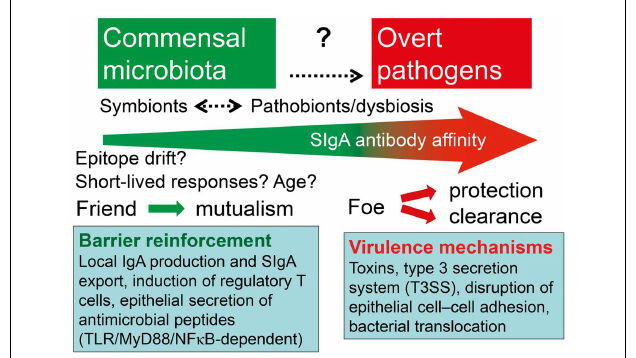
FIGURE 8 | Hypothetical depiction of how the intestinal immune system handles symbionts and potentially pathogenic residents (pathobionts) of the commensal microbiota versus overt exogenous pathogens . Secretory IgA (SIgA) antibody levels against commensal bacteria may go in waves because of epitope drift and shielding of gut-associated lymphoid tissue from antigen uptake.The overall affinity of SIgA antibodies probably increases with age and may be enhanced or reduced against pathobionts during dysbiosis, and particularly raised by persistent stimulation with overt pathogens. One goal of mutualism with commensals is mucosal barrier reinforcement by mechanisms listed such as SIgA export and induction of regulatoryT cells, whereas pathogens exhibit various virulence mechanisms to break the